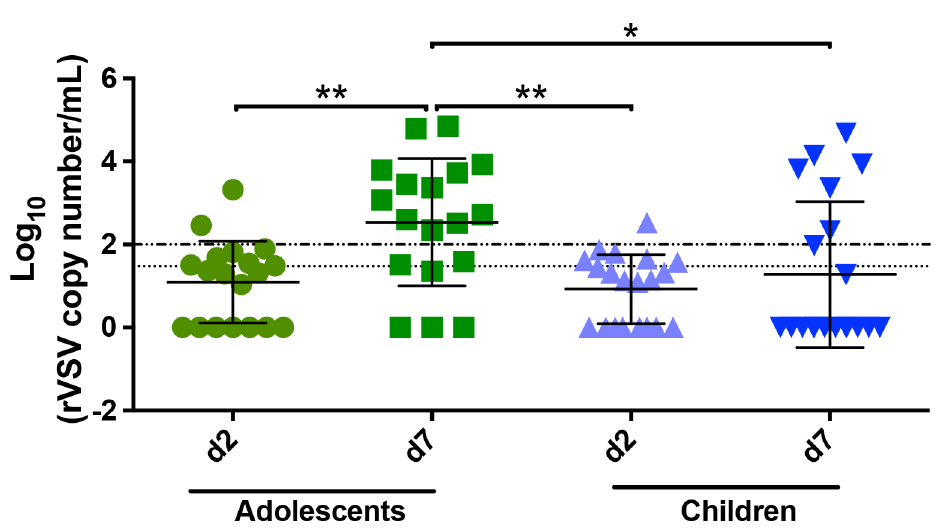
Fig 2. Viral load in saliva for children and adolescents. rVSV Δ G-ZEBOV-GP (rVSV) RNA copy numbers in saliva presentedas log10 rVSV RNA copies/ml from day 2 and 7 (d2 and d7) post-injection in adolescents and children vaccinatedwith 2 × 10 7 PFU. The broken line denotesthe limit of quantitation, and the dotted line denotesthe limit of detection. About 67% (12/18) and 30% (6/20) adolescents and children,respectively,had samples abovethe limit of quantification at day 7. * P < 0.05; ** P < 0.01.PFU, plaque-forming units.